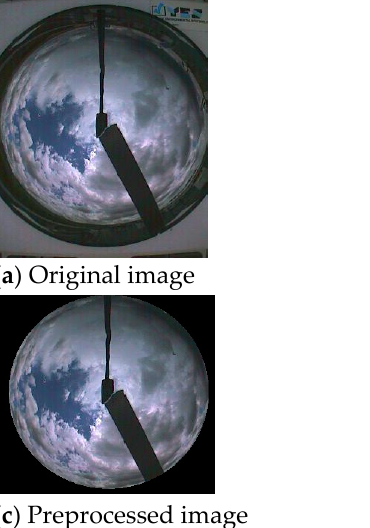
Figure 2. The preprocessing of a total sky image to extract the regions of interest.